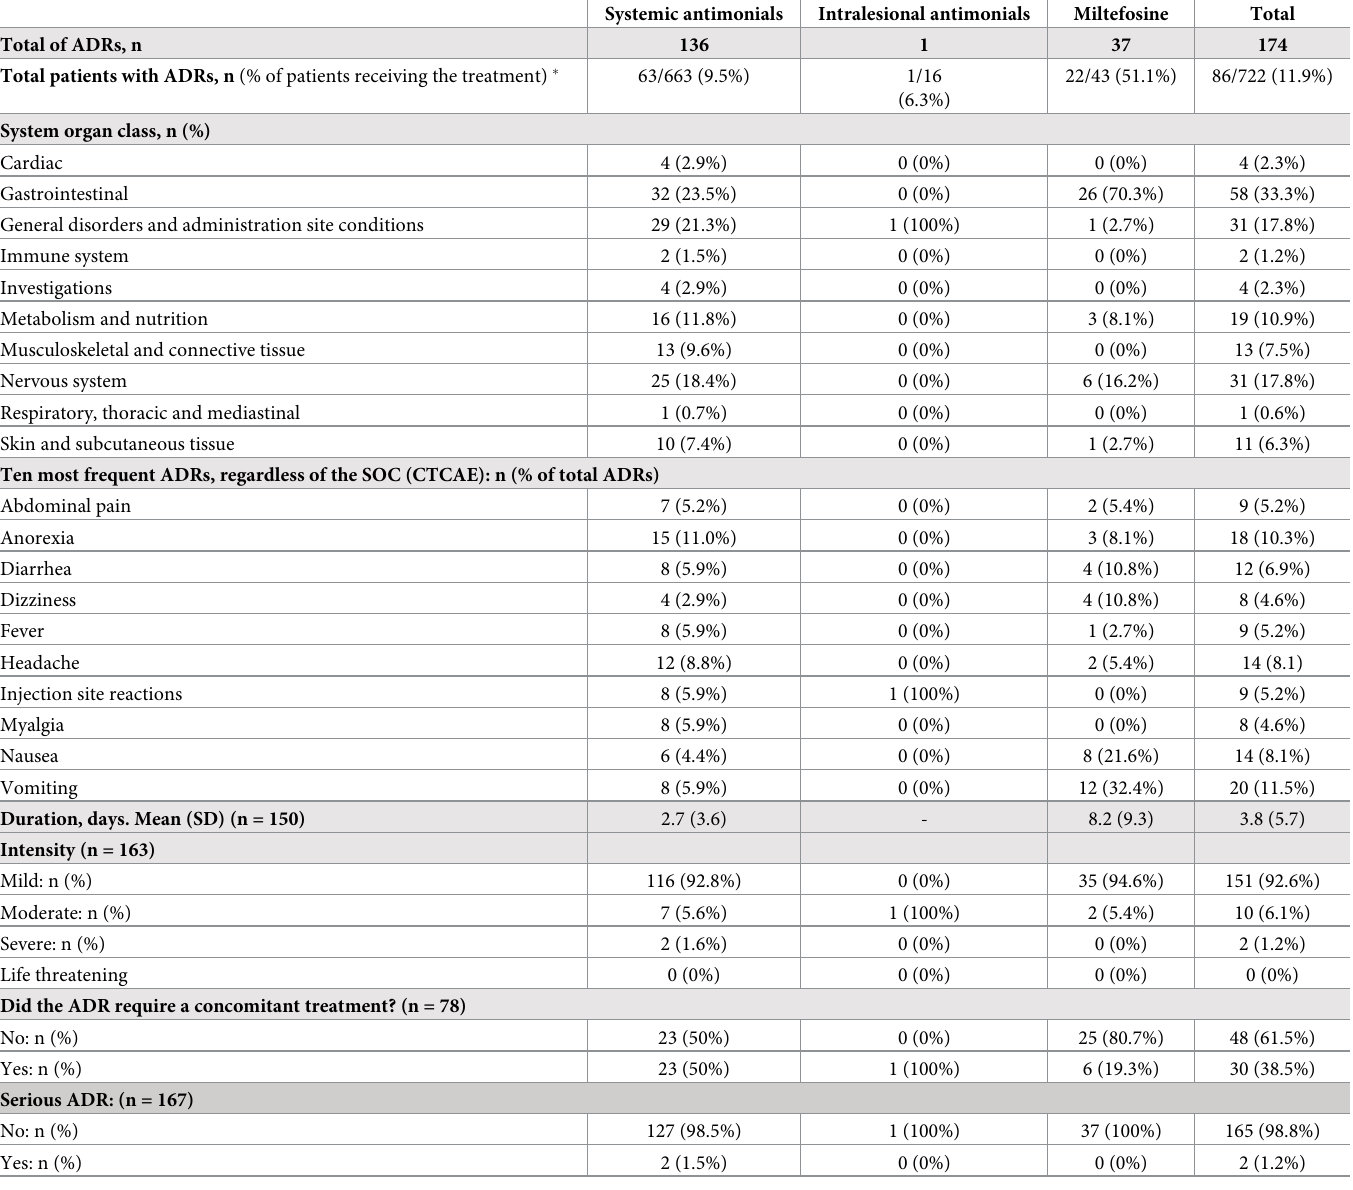
Table 4. Adverse drug reactions in